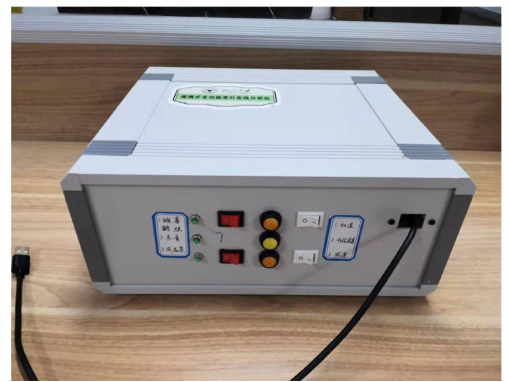
Figure 5. The overall appearance of the electronic nose